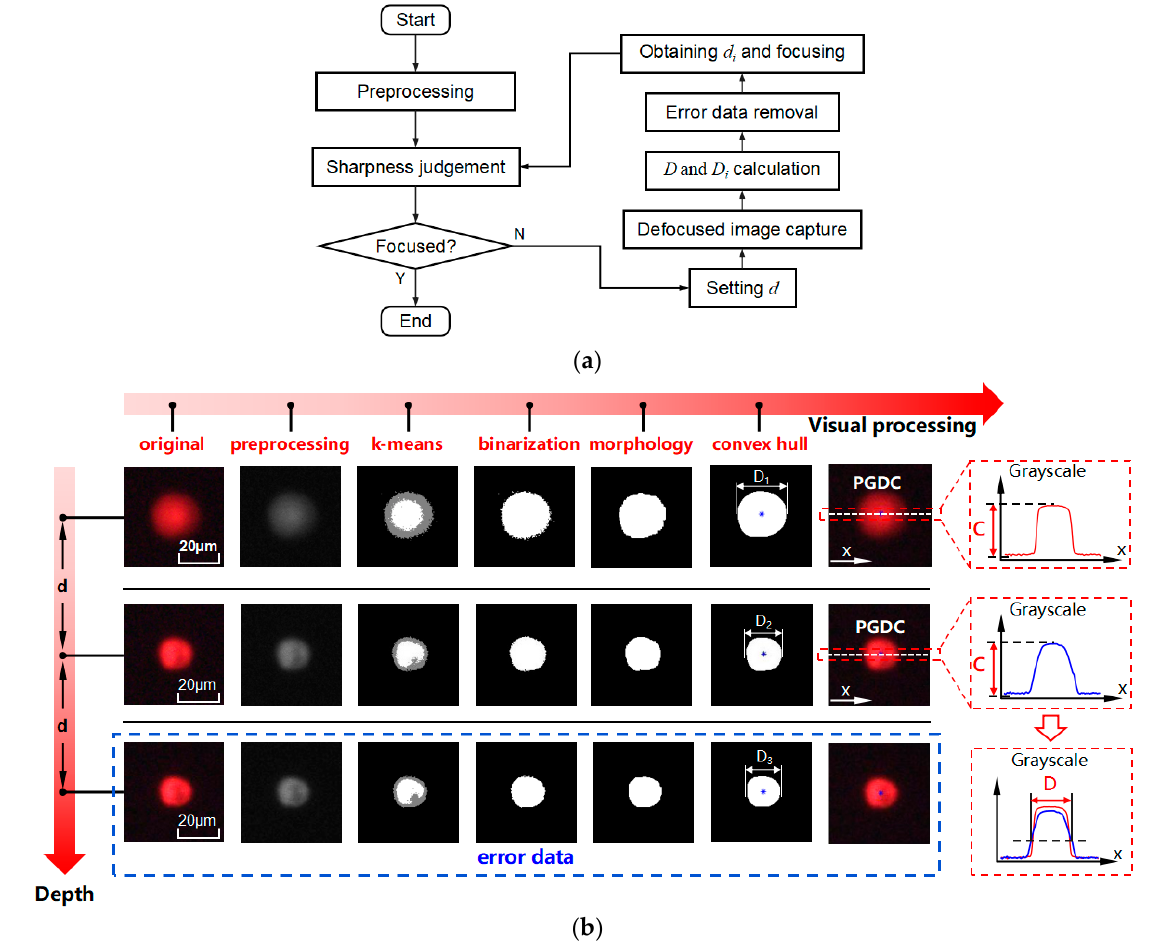
Figure 6. The theory of multiple depth from defocus (MDFD): ( a ) Flow chart of MDFD; ( b ) Visual processing of MDFD.